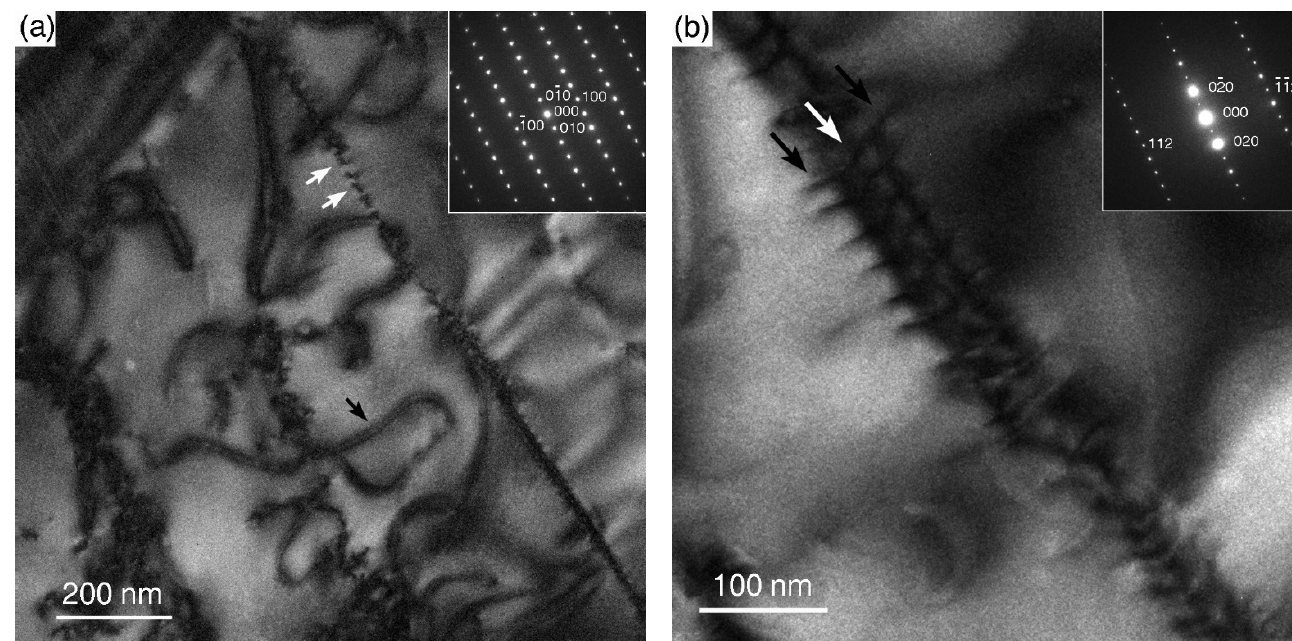
Figure 4. ( a ) BF image with [001] incidence. A line of end-on screw dislocations is shown (such as that indicated by the white arrow). This sub-grain boundary is parallel to (100). Some curved dissociated dislocations are shown (such as that indicated by the black arrow). The dissociation width varies from 10 to 25 nm. ( b ) BF image with [20-1] incidence. The sub-grain boundary in ( a ) exhibits a kink band (indicated by the white arrow) on the screw dislocation wall (black arrows).